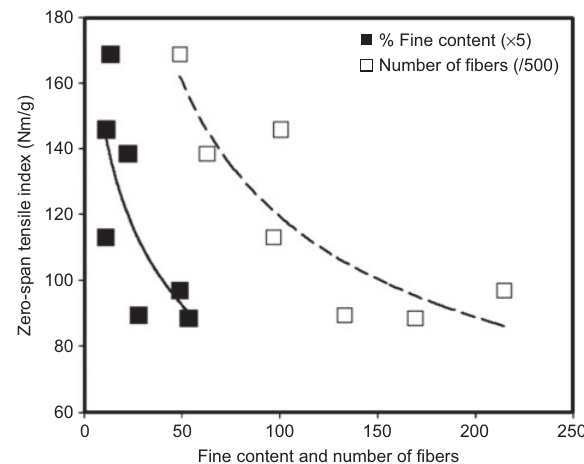
Figure 5 Increasing fine content and number of fibers in a given amount of pulp promoted tensile index of final